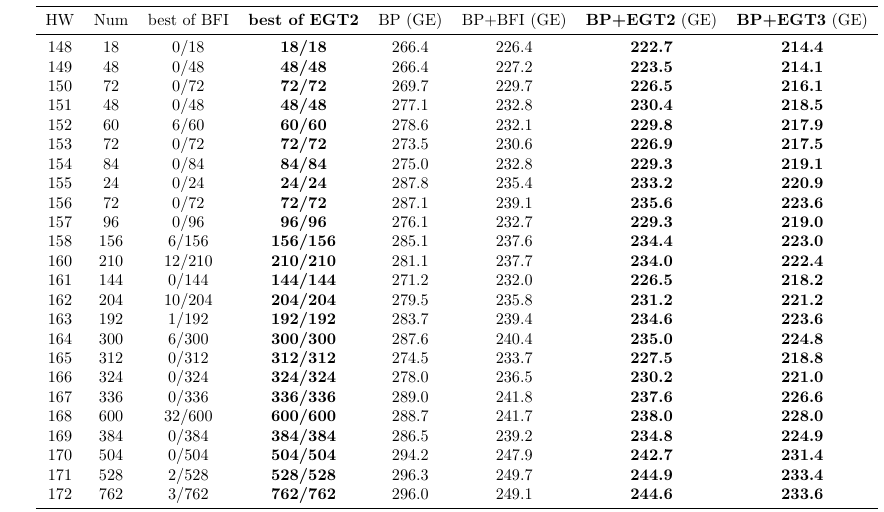
Table 10: The results of implementation cost of matrices from [LSL + 19] for STM 130 nm